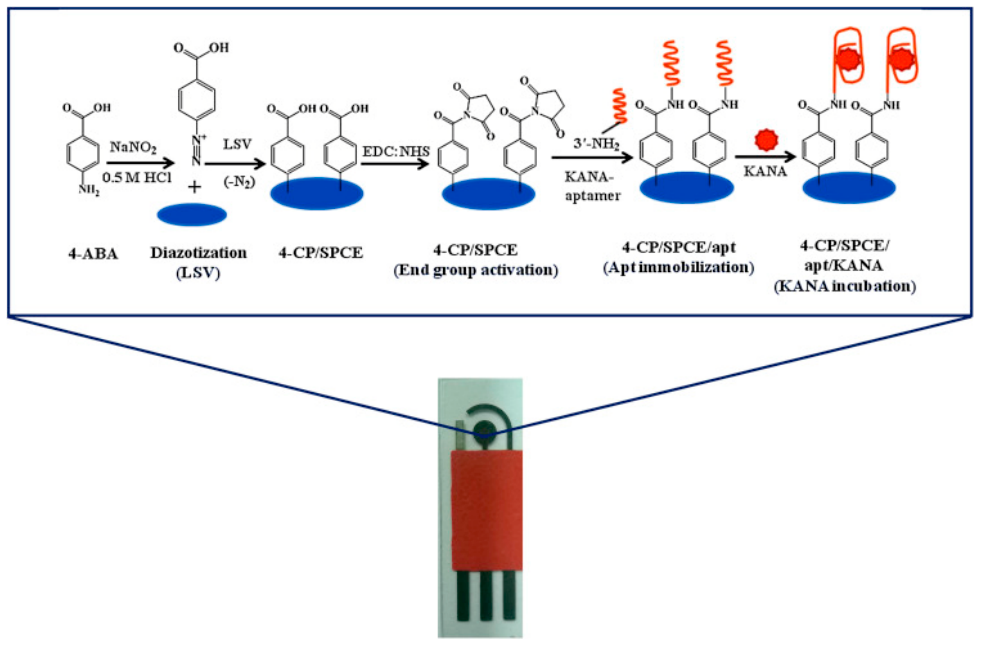
Figure 3. Schematic representation of surface modification and fabrication of an aptasensor for kanamycin (KANA) detection (reprinted with permission from [45]). Table 1. Electrochemical biosensors for the determination of kanamycin in food samples.